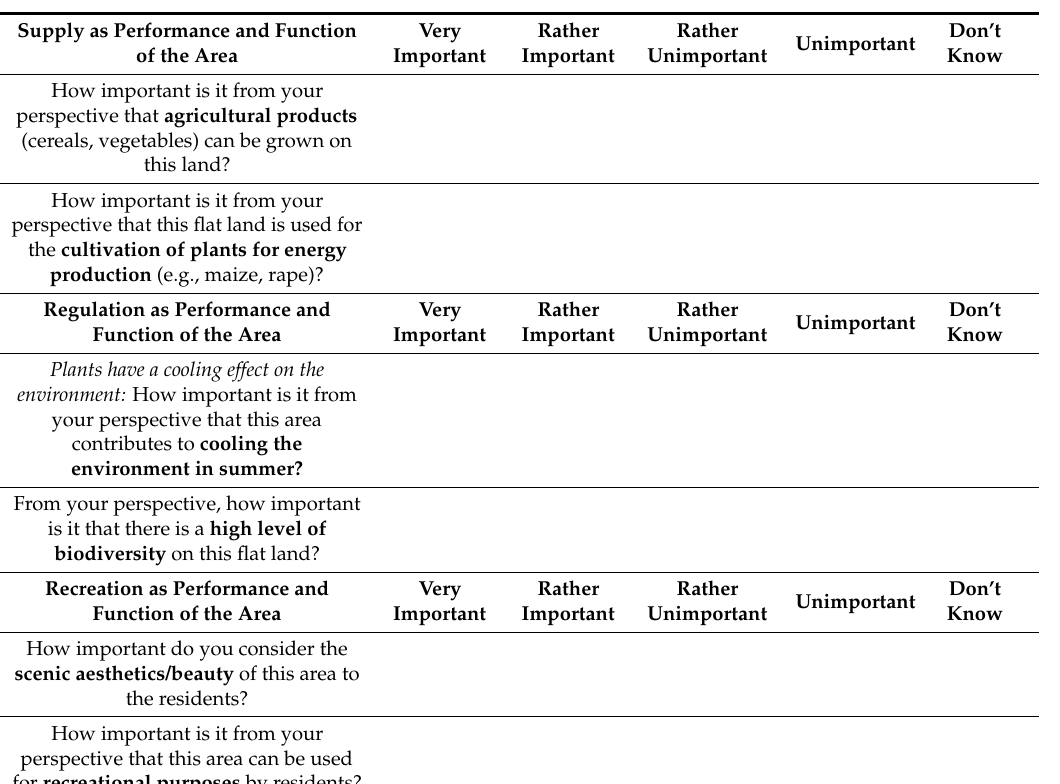
Table A3. ESD questionnaire (translated, excerpt). In the following questions we would like to ask you for your opinion regarding the importance of certain services and functions that the green area/open space with its surroundings offers or can offer. Are the services and functions from your perspective as a planner very important, rather important, rather unimportant, or unimportant? If you are unable or unwilling to provide any information on an aspect, please tick the “no information”